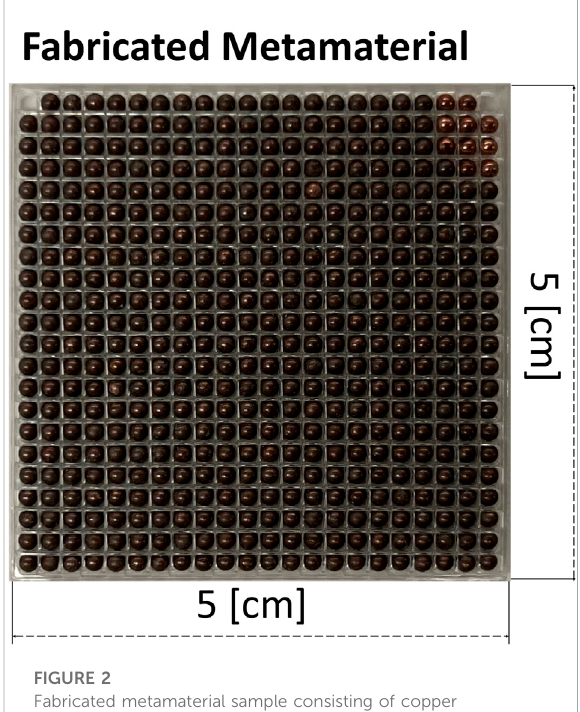
Fabricated metamaterial sample consisting of copper spheres embedded in a PLA